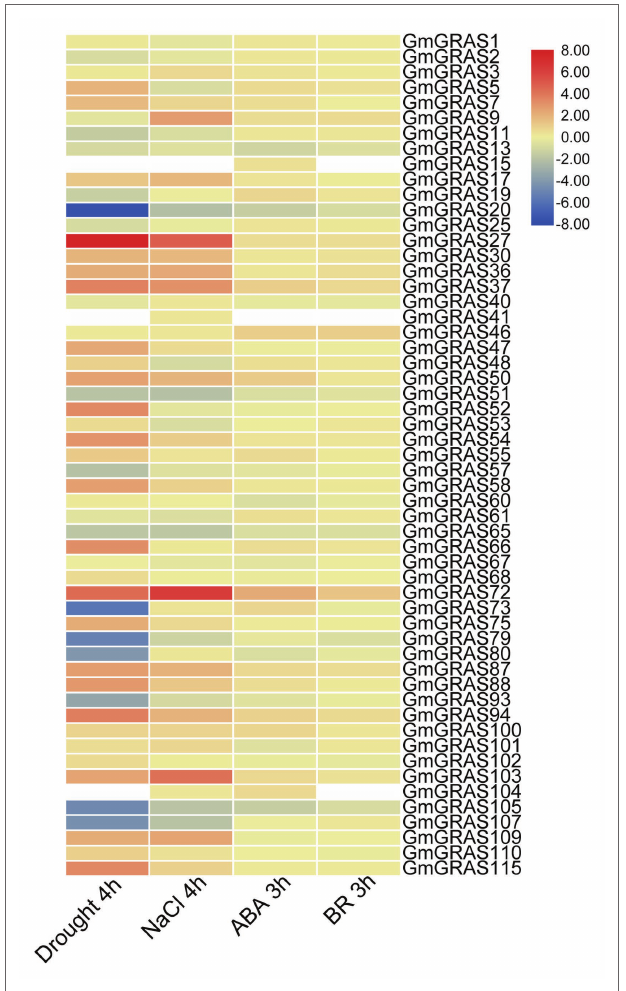
FIGURE 9 | Heat map of expression profiles of all GmGRAS genes under different abiotic stresses. The expression abundance of each transcript (in log10-based FPKM) is represented by the color: red, higher expression; blue, lower expression; white, miss value.